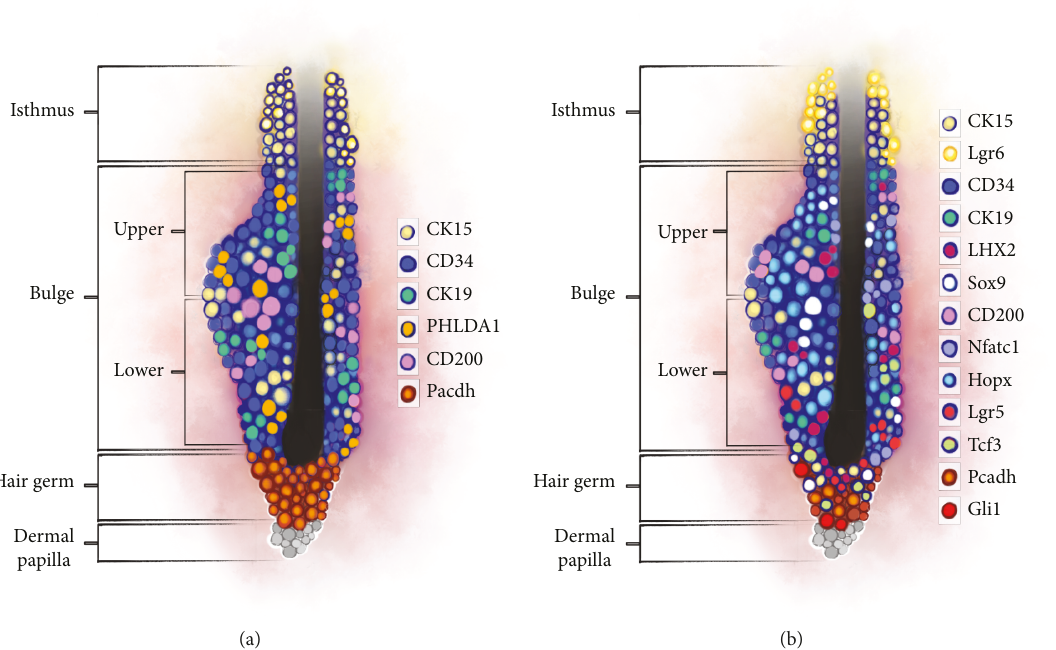
Figure 2: The markers of hair follicle: (a) in human, (b) in